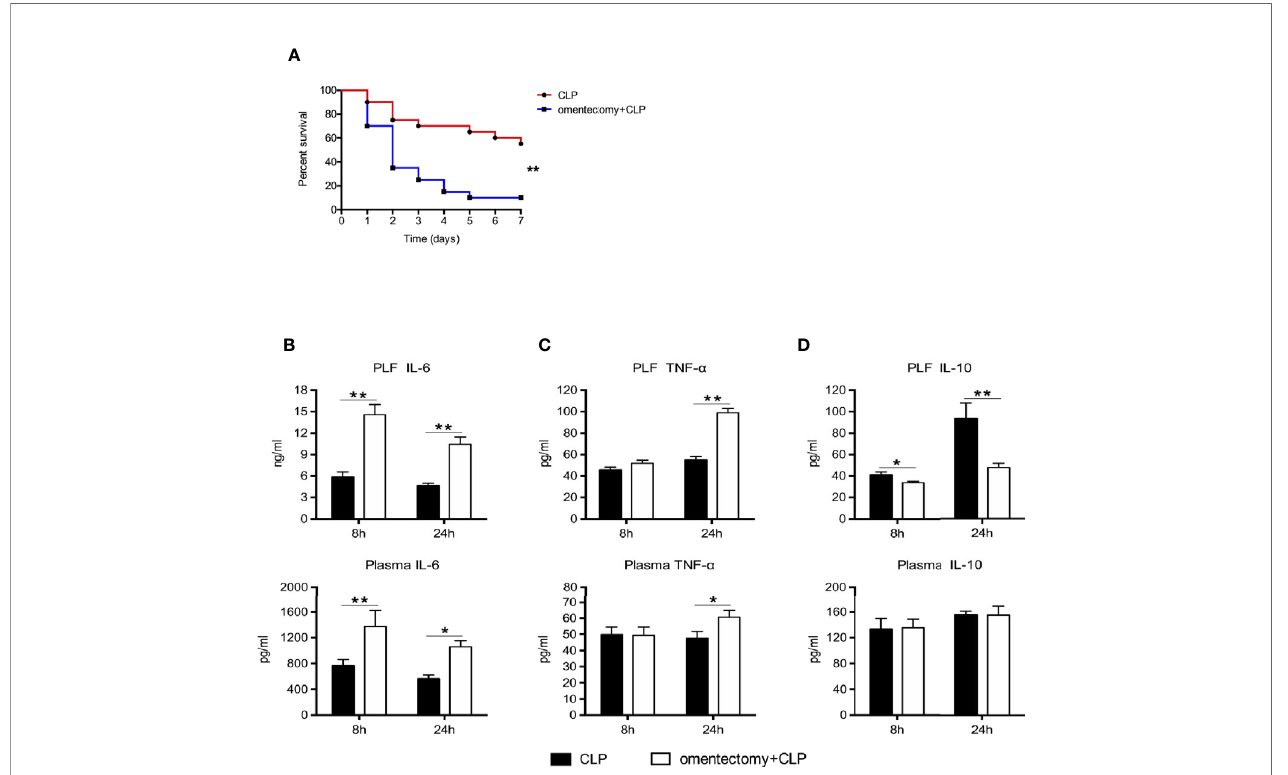
FIGURE 1 | The removal of the omentum aggravates the systemic in fl ammation and reduces survival after CLP. (A) Mice were subjected to CLP or omentectomy +CLP (n = 20 per group). The survival rates were evaluated for consecutive 7 days after CLP. Statistical difference was determined by the log-rank test. At the 8 and 24 h after CLP, PLF and blood samples were collected, and the level of IL-6 (B) , TNF- a (C) , and IL-10 (D) (n = 9~10 per group) were determined. All values are shown as means ± SEM from 3 separate experiments. ** p < 0.01 and * p < 0.05 for omentectomized vs